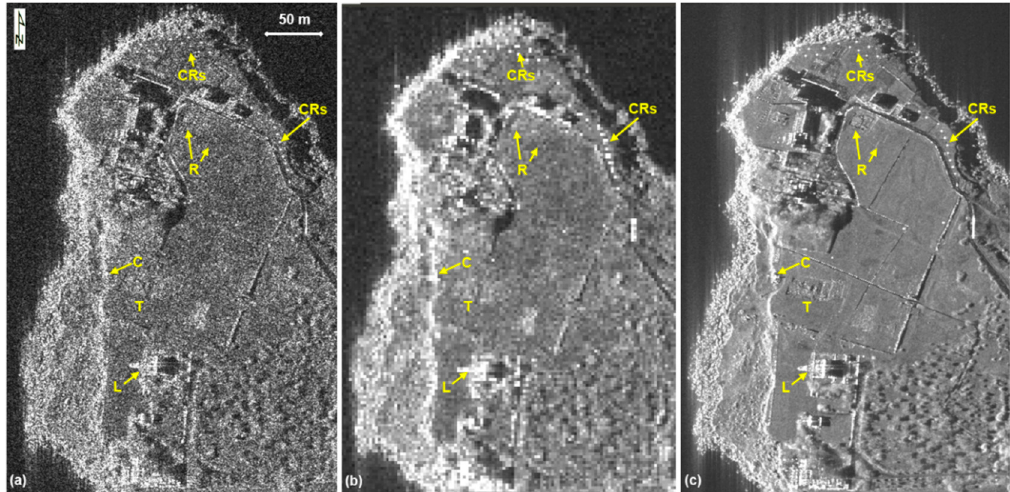
Figure 4. Comparison of a COSMO-SkyMed Enhanced Spotlight image at 1-m ground resolution acquired on 14/08/2018 in descending mode, using an incidence angle of 42°, over the archaeological site of Capo Colonna, southern Italy: ( a ) prior; and ( b ) after multi-looking. ( c ) Multi-temporal average of 54 COSMO-SkyMed Enhanced Spotlight images acquired in 2017–2018. Notation of the features on the ground: T, Temple of the goddess Hera; C, monumental Doric column of the temple; R, archaeological ruins; L, lighthouse; CRs, corner reflectors installed to monitor the stability of the northern cliff. COSMO-SkyMed® Products ©ASI—Italian Space Agency—2017–2018. All Rights Reserved.